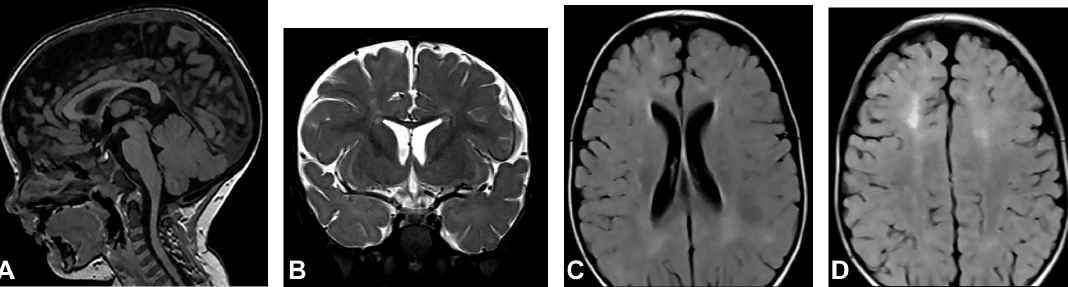
Figure 1. (Case 1) ( A ) Sagittal T1 MPRAGE magnetic resonance image at the age of two shows macrocrania, thinning of CC and a pineal gland cyst. ( B ) Coronal T2W magnetic resonance plane shows mild atrophy of bilateral frontal white matter with dilated extracerebral liquor spaces. ( C , D ) Axial T2 FLAIR magnetic resonance planes show that lateral ventricles are slightly dilated with gliotic changes in periventricular and frontal regions.